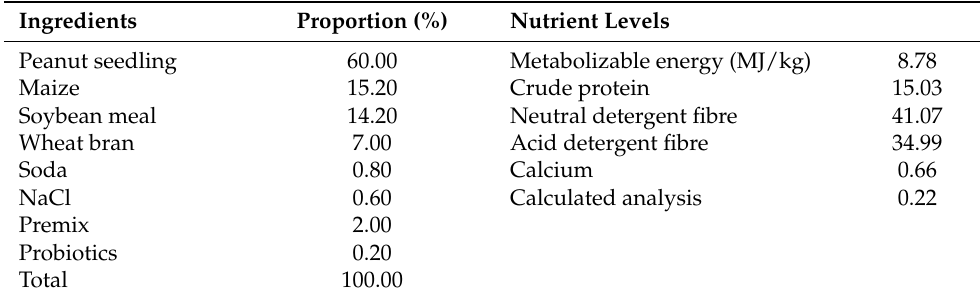
Table 1. Dietary formula for fistulated goats (air-dried